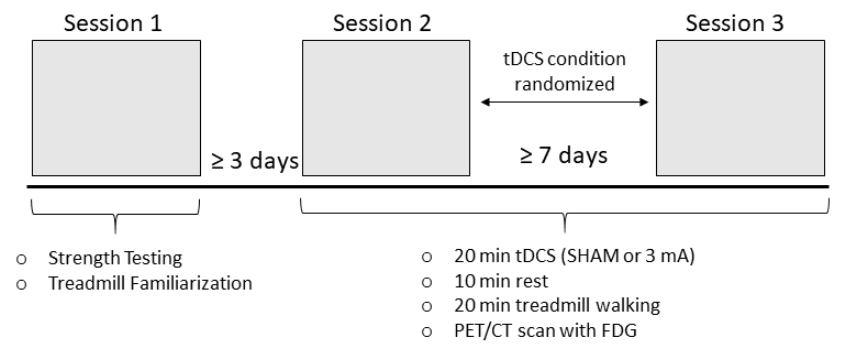
Figure 1. Experimental protocol. Subjects attended three total sessions. During Session 1, subjects completed isokinetic strength testing to determine their more-affected leg and self-selected their treadmill walking speed for subsequent sessions. During Session 2 and 3, subjects underwent 20 min of either SHAM or 3 mA transcranial direct current stimulation (tDCS (determined through randomization) over the motor cortex area representing their more-affected leg, a 10-min rest, then 20 min of treadmill walking. After the walking task, the subjects underwent a positron emission tomography/computed tomography (PET/CT scan with fluorodeoxyglucose